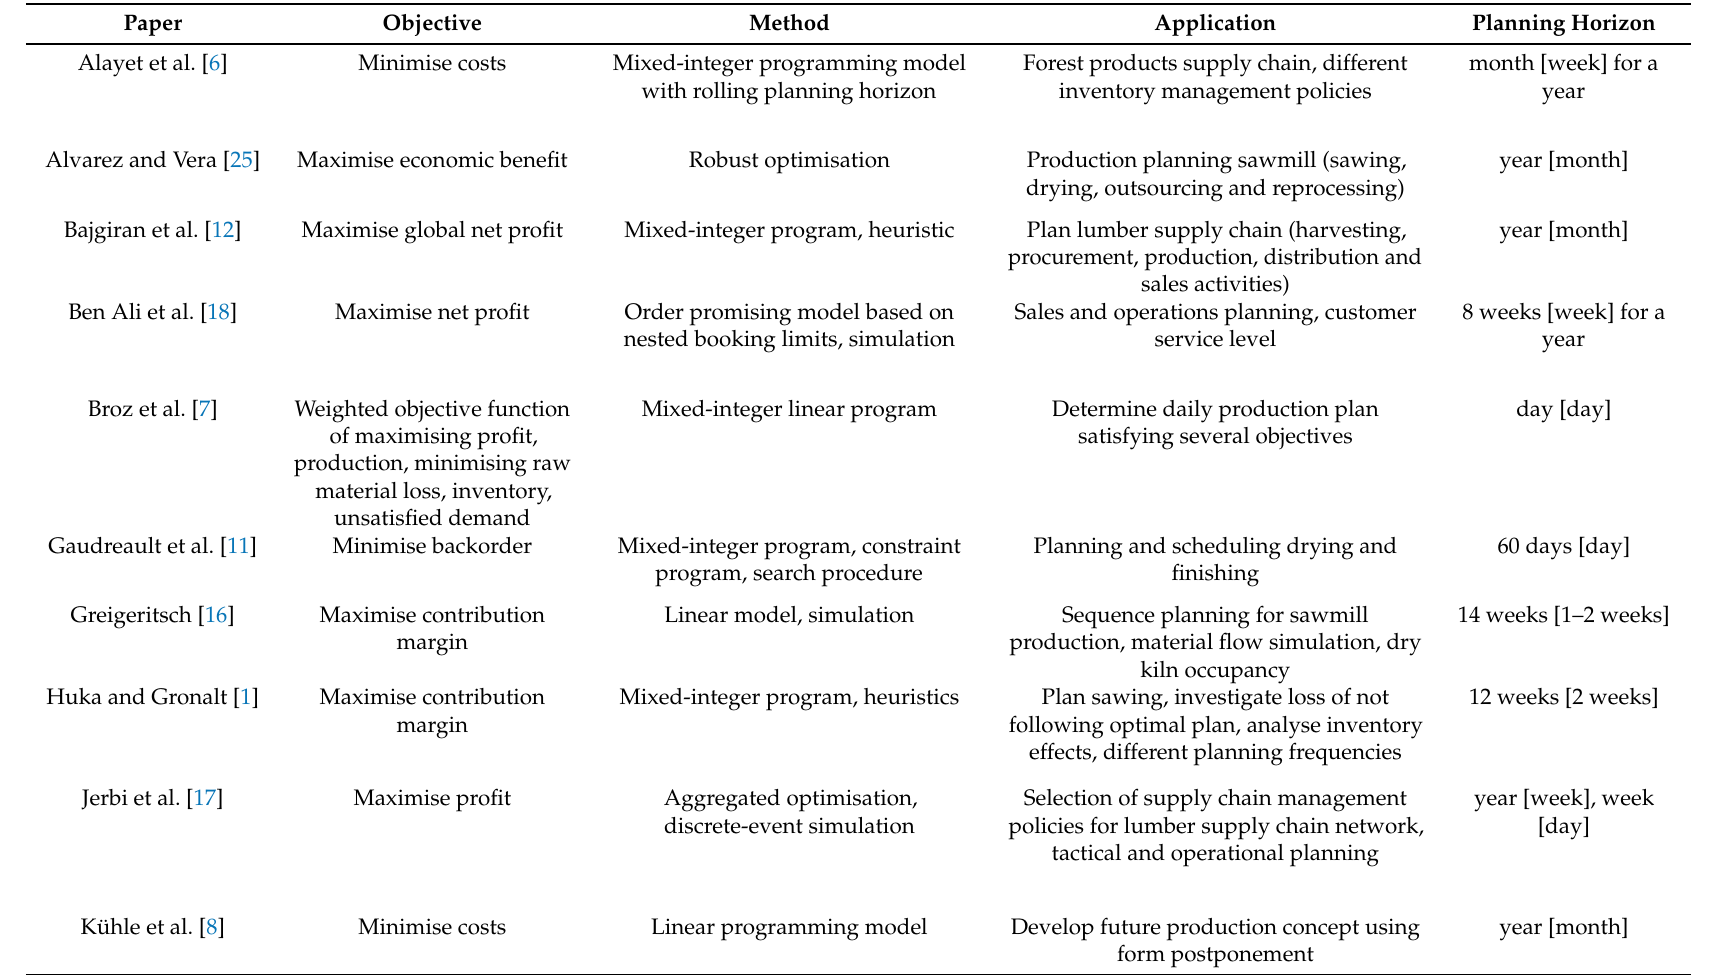
Table 1. Existing literature in the field of production planning in the primary wood industry. The objectives pursued, the methods used, the general scope of the models presented and the used planning